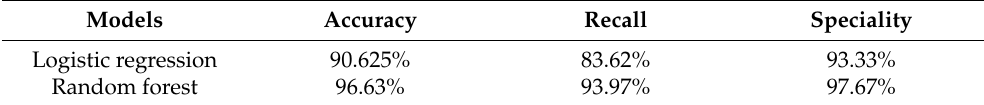
Table 3. Comparison of performance